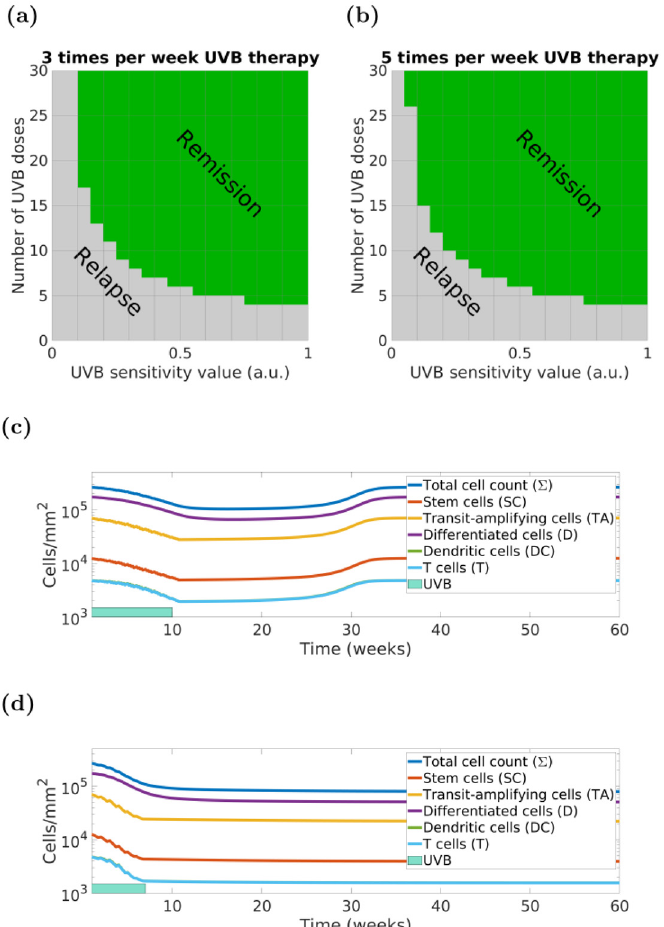
Fig 4. Our ODE model predicts that the total number of UVB doses, irradiation frequency and the patient’s UVB sensitivity (modelled by the uvb s parameter) are the key factors in designing a personalised therapy for achieving psoriasis clearance and remission. Panels: (a) and (b)—green areas contain the values for which the model predicts remission following the therapy; (c) and (d): personalised model simulation of a virtual patient ( uvb weekly phototherapy (c) fails to clear psoriasis while 5x weekly phototherapy (d) with the same doses ( n = 30) succeeds.